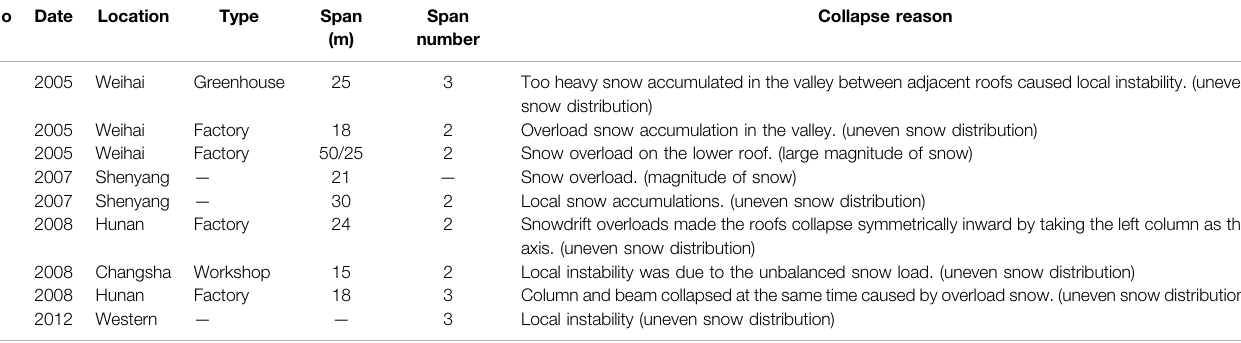
TABLE 1 | Examples of collapsed two-span roofed buildings in snow